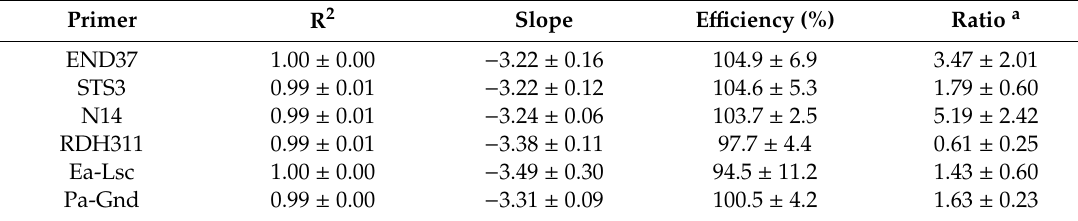
Table 4. qPCR assay performance of pTotalStdA three dilution standard curve and its accuracy of genome